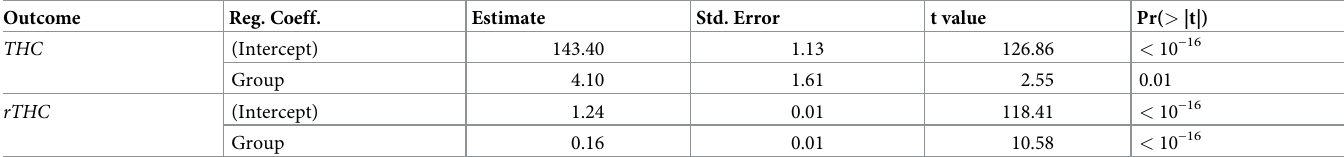
Table 1. The estimate of group effect in the SMM for THC and rTHC at γ = 0.5. Outcome Reg. Coeff.